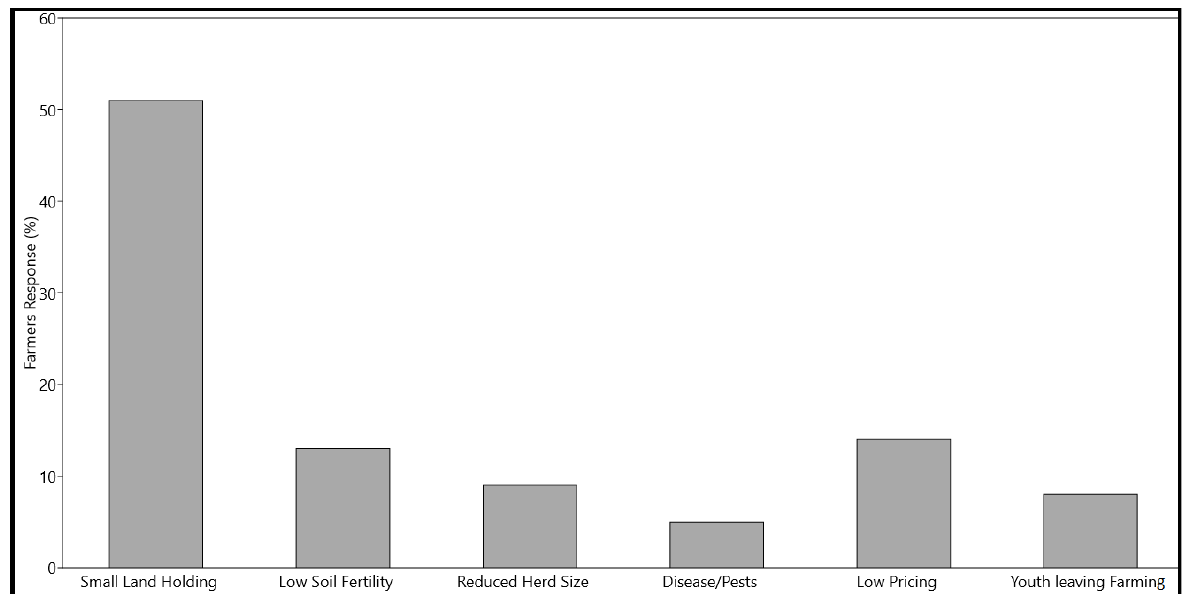
Figure 4. Farmers ’ responses regarding the major challenges faced in the bean production in the Figure 4. Farmers’ responses regarding the major challenges faced in the bean production in the AJK region. AJK